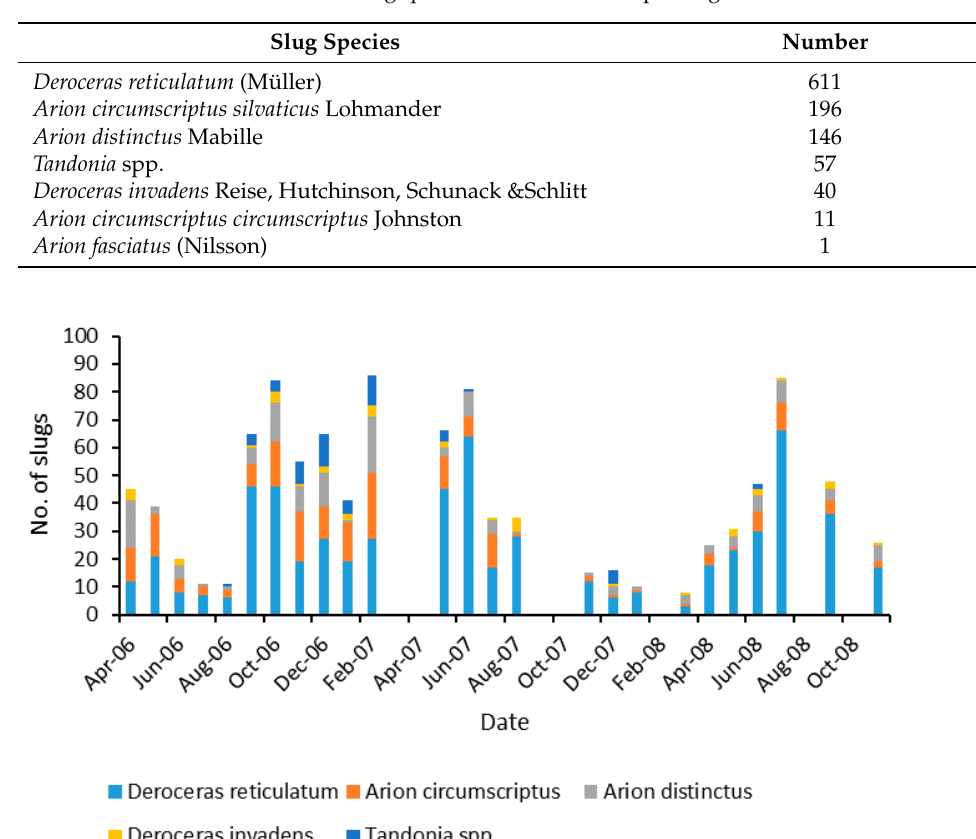
Figure 1. The numbers of different slug species collected from traps at a grassland site over 32 months.